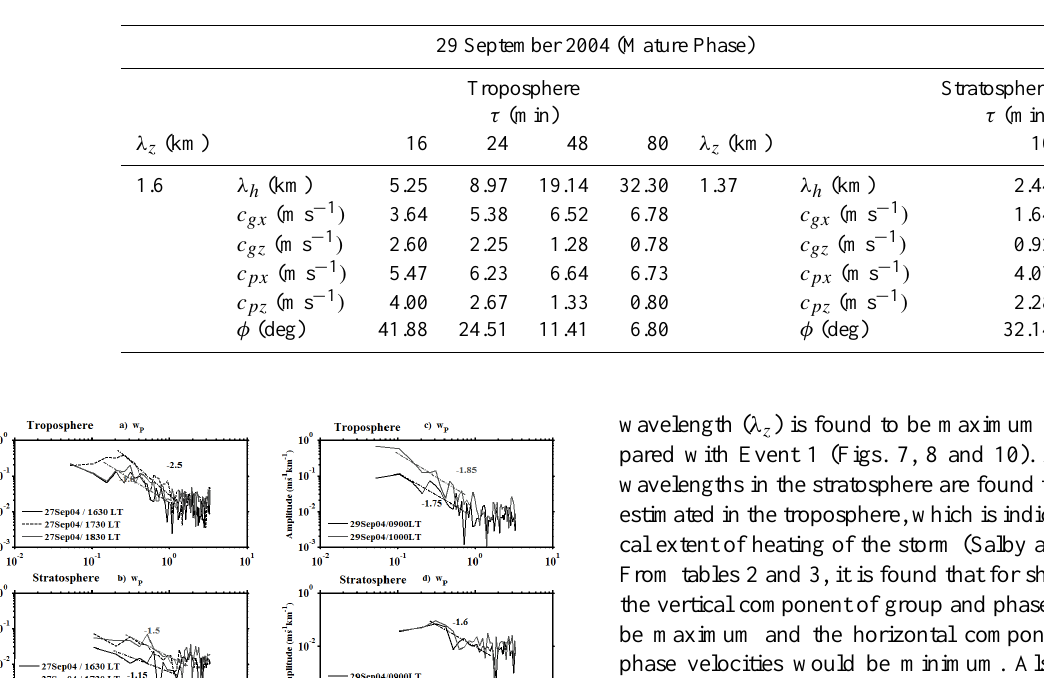
Table 3. Same as Table 2 for 29 September 2004.